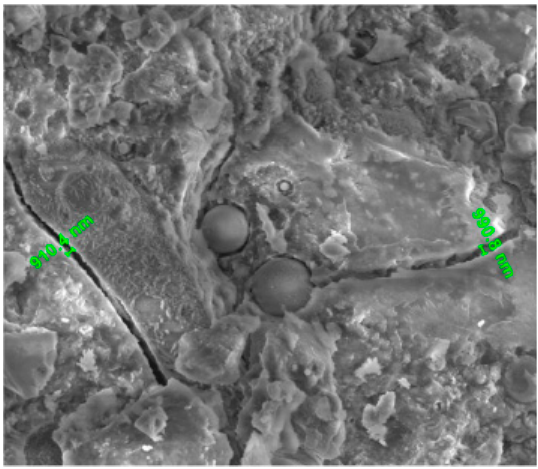
Figure 8. SEM image of concrete with 1% CNFs (5000× magnification). Reproduced from [27], with permission from Elsevier, 2019.